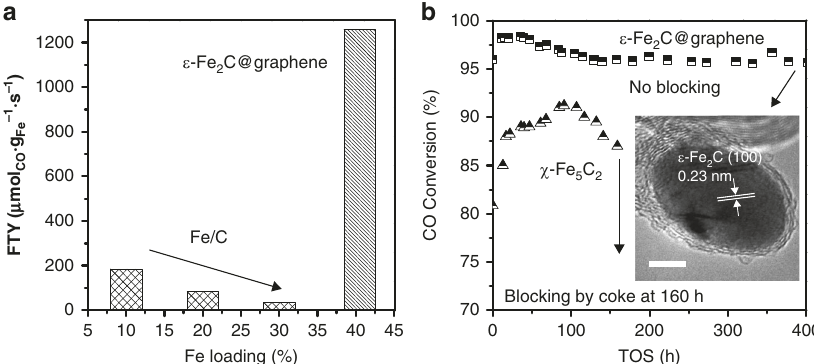
Fig. 4 Catalytic performance of different iron catalysts. a Comparison of FTY values between ε -Fe 2 C@graphene catalyst and iron catalyst loaded on active carbon with different iron loadings. b Long-term stability of ε -Fe 2 C@graphene and un-encapsulated χ -Fe 5 C 2 catalysts. Reaction conditions: H 2 /CO = 1/1, 573 K, p = 10 bar. The insert shows the high-resolution TEM micrograph for the spent ε -Fe 2 C@graphene catalysts after 400h reaction.